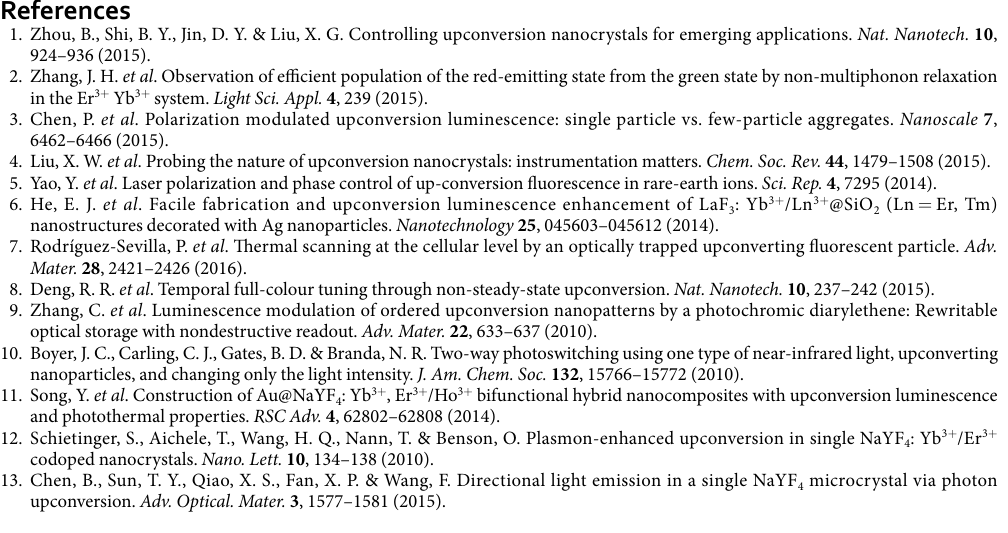
luminescence flower from blooming to withering and directional red emission are presented by simply adjusting the focal point position of the excitation light. It is suggested that the internal reflection and light waveguide effect determine the typical feature of the UC emission from the microcrystal particle. The current design and study should have great significance in the development of micro-optoelectronic devices, pattern-changeable three-dimensional color display, and directional light emission and micro-laser systems.